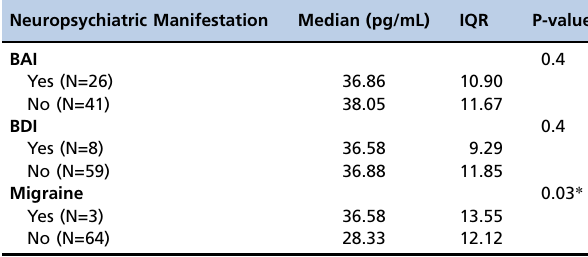
Table 3 - Serum IL-17 levels compared with the main neuropsychiatric manifestations. Neuropsychiatric Manifestation